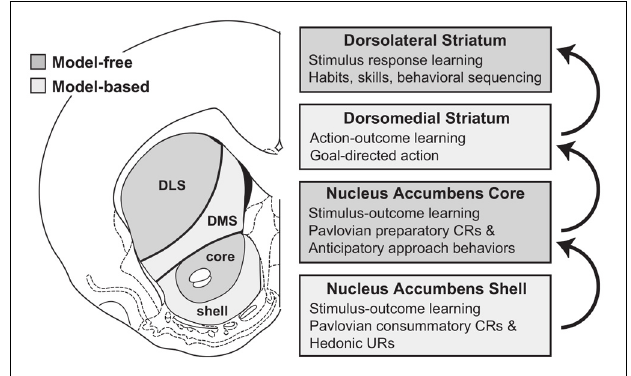
FIGURE 7 | The proposal of Penner and Mizumori (2011) for the possible functions of nucleus accumbens core and shell, and their relation to downstream striatal regions. Notice the role of stimulus-outcome predictor ascribed to the accumbens. Reprinted from Penner and Mizumori (2011), Copyright 2011, with permission from Elsevier.